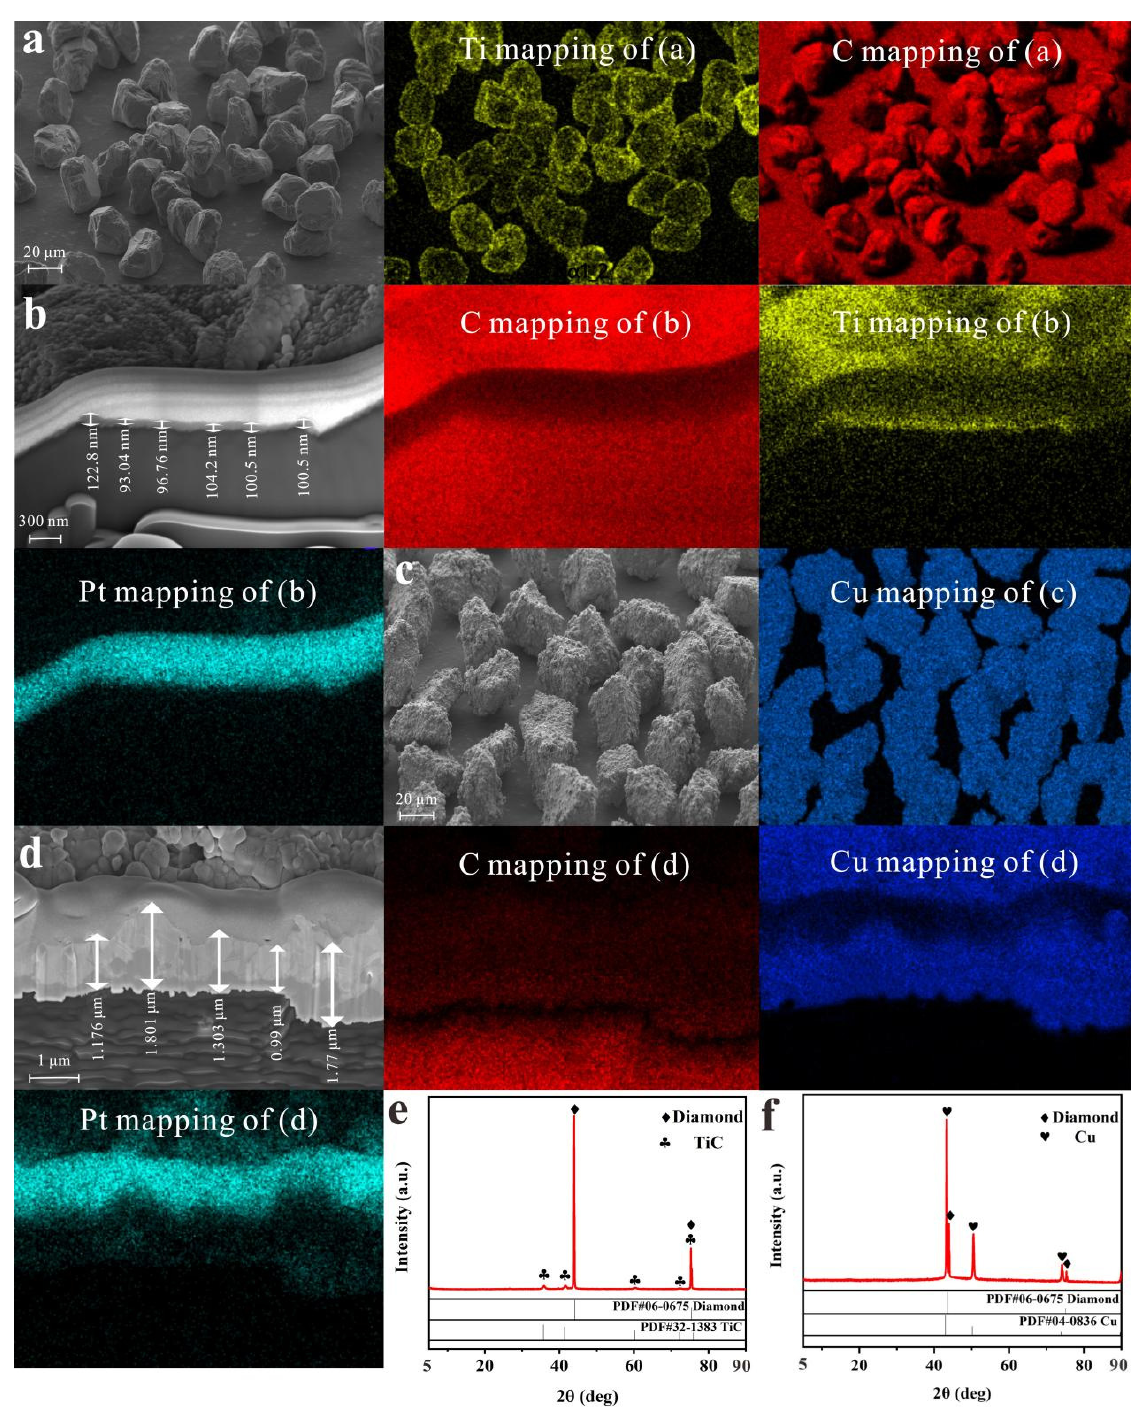
Figure 2. ( a ) The morphologies of the titanium-coated diamond particles and the corresponding EDS element mappings; ( b ) The thickness of the titanium-coating layer on the diamond particle surface and the corresponding EDS element mappings; ( c ) The morphologies of the copper-coated diamond particles and the corresponding EDS element mappings; ( d ) The thickness of the copper-coating layer on the diamond particle surface and the corresponding EDS element mappings; The XRD pattern of ( e ) the titanium-coated and ( f ) the copper-coated diamond particles.